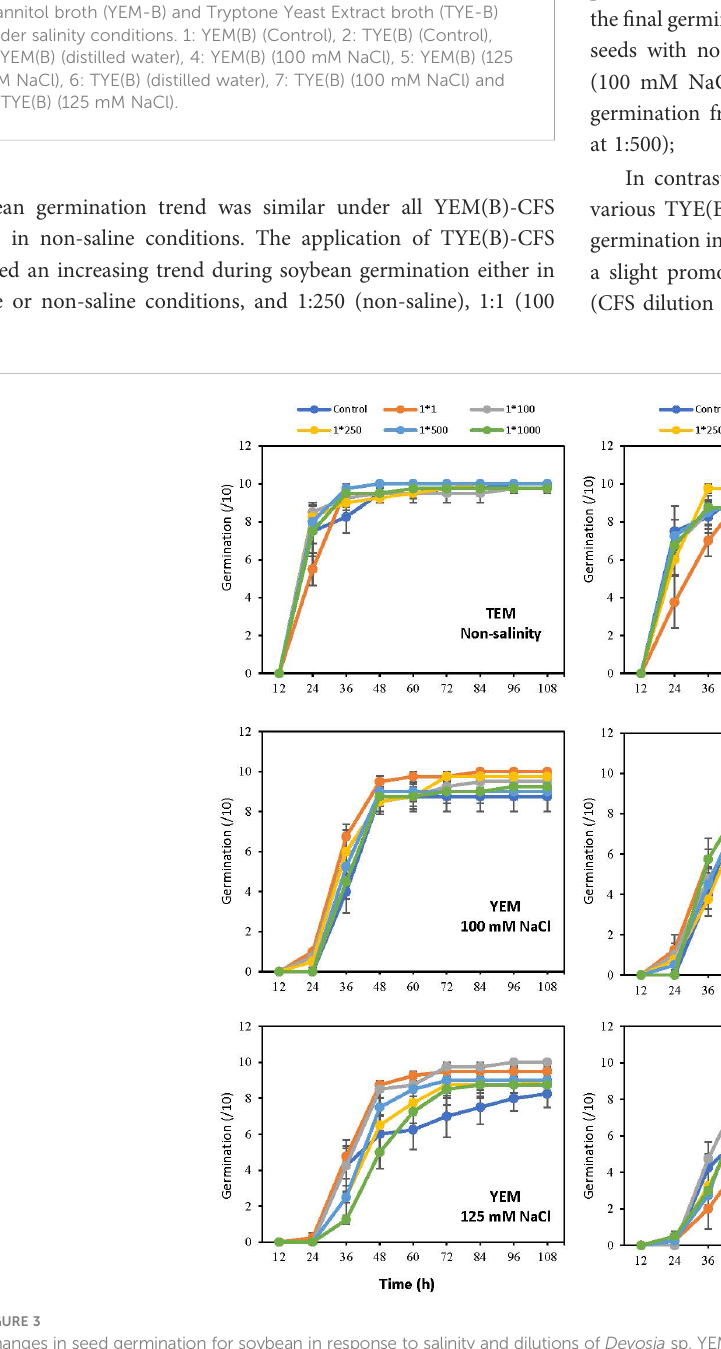
FIGURE 2 Changes in growth of Devosia sp. (SL43 strain) in Yeast Extract Mannitol broth (YEM-B) and Tryptone Yeast Extract broth (TYE-B) under salinity conditions. 1: YEM(B) (Control), 2: TYE(B) (Control), 3: YEM(B) (distilled water), 4: YEM(B) (100 mM NaCl), 5: YEM(B) (125 mM NaCl), 6: TYE(B) (distilled water), 7: TYE(B) (100 mM NaCl) and 8: TYE(B) (125 mM